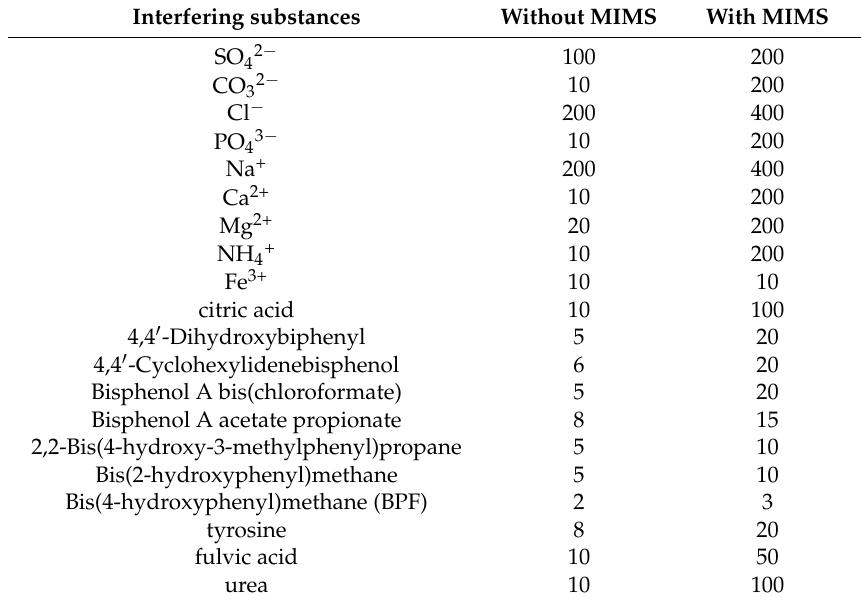
Table 1. Tolerable ratio of structural analogues and some interfering species to BPA with and without MIP. Interfering substances Without MIMS With MIMS